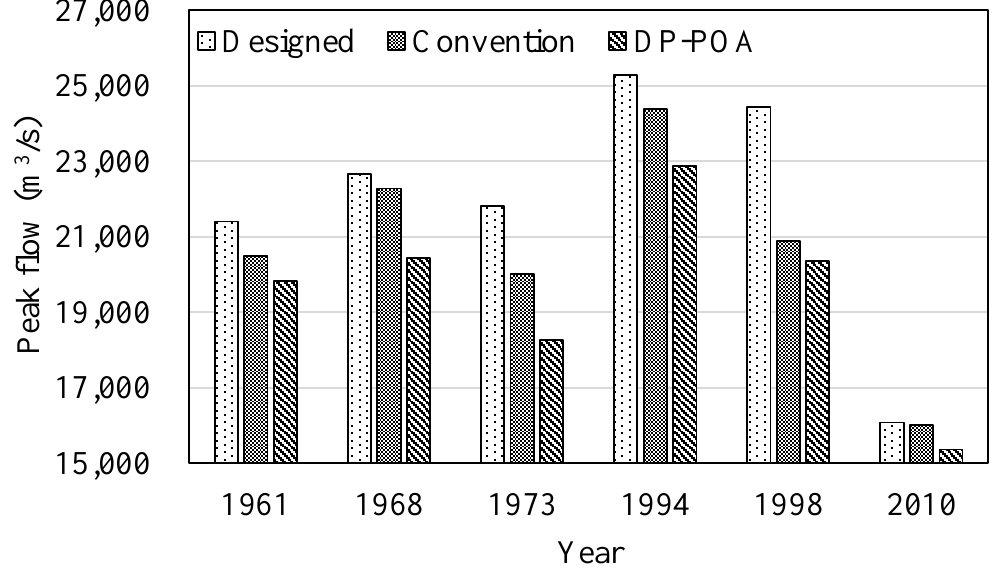
Figure 5. Flood peaks of the Ji’an flood control point with 100-year return period.